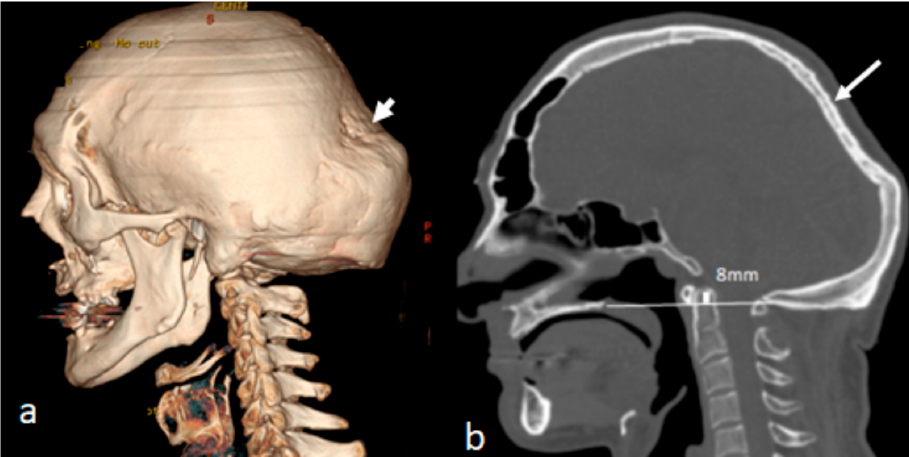
Figure 3. ( a , b ) Three-dimensional reconstruction CT scan of the skull of a 28-year-old patient with OI type IVB showing the massive bulging of the occipital area secondary to progressive softening and thinning of the occipital bones, causing a severe bulge over the lambdoid sutures (note the overly stretched pastry-like phenotype—arrow) leading to downward shifting of the skull with subsequent upwards ascending of the dens into the brain stem. His genotype exhibited a carrier of the heterozy- gote mutation of COL1A2 , NM_000089.3c.1801>A , p.(Gly601 Ser.) ( a ). Three-dimensional sagittal CT scan of the craniocervical junction showing immense thinning of the occiput (arrow) and downward bulging around the borders of the lambdoid sutures. Pathological upward bulging of the dens 8 mm above Chamberlain’s line causing the development of subclinical basilar invagination ( b ).